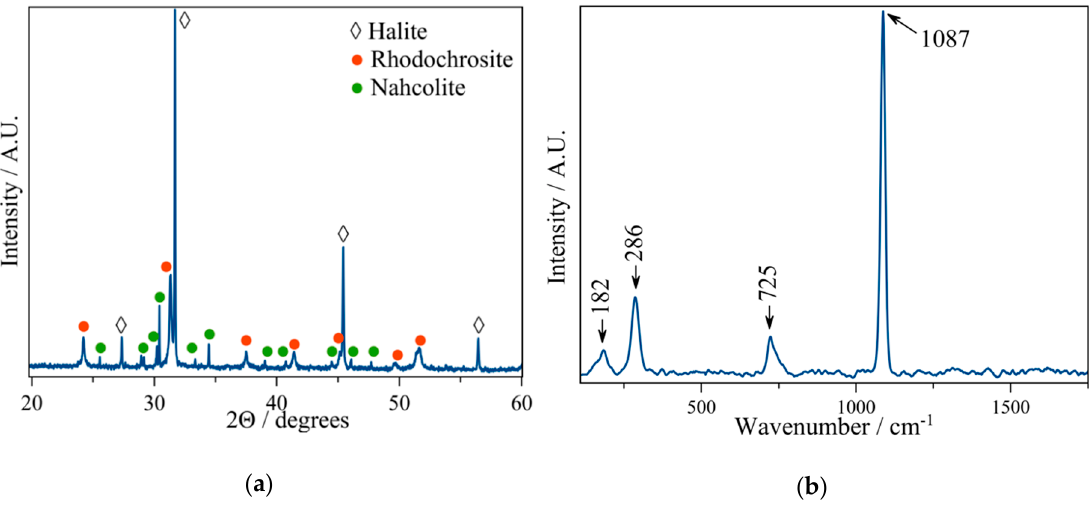
Figure 10. ( a ) Powder X-ray diffractogram; ( b ) Raman spectra of manganese vesicles (182, 286 cm − 1 —translational lattice modes; 725 cm − 1 —in-plane bending mode; 1087 cm − 1 —symmetric stretching mode).